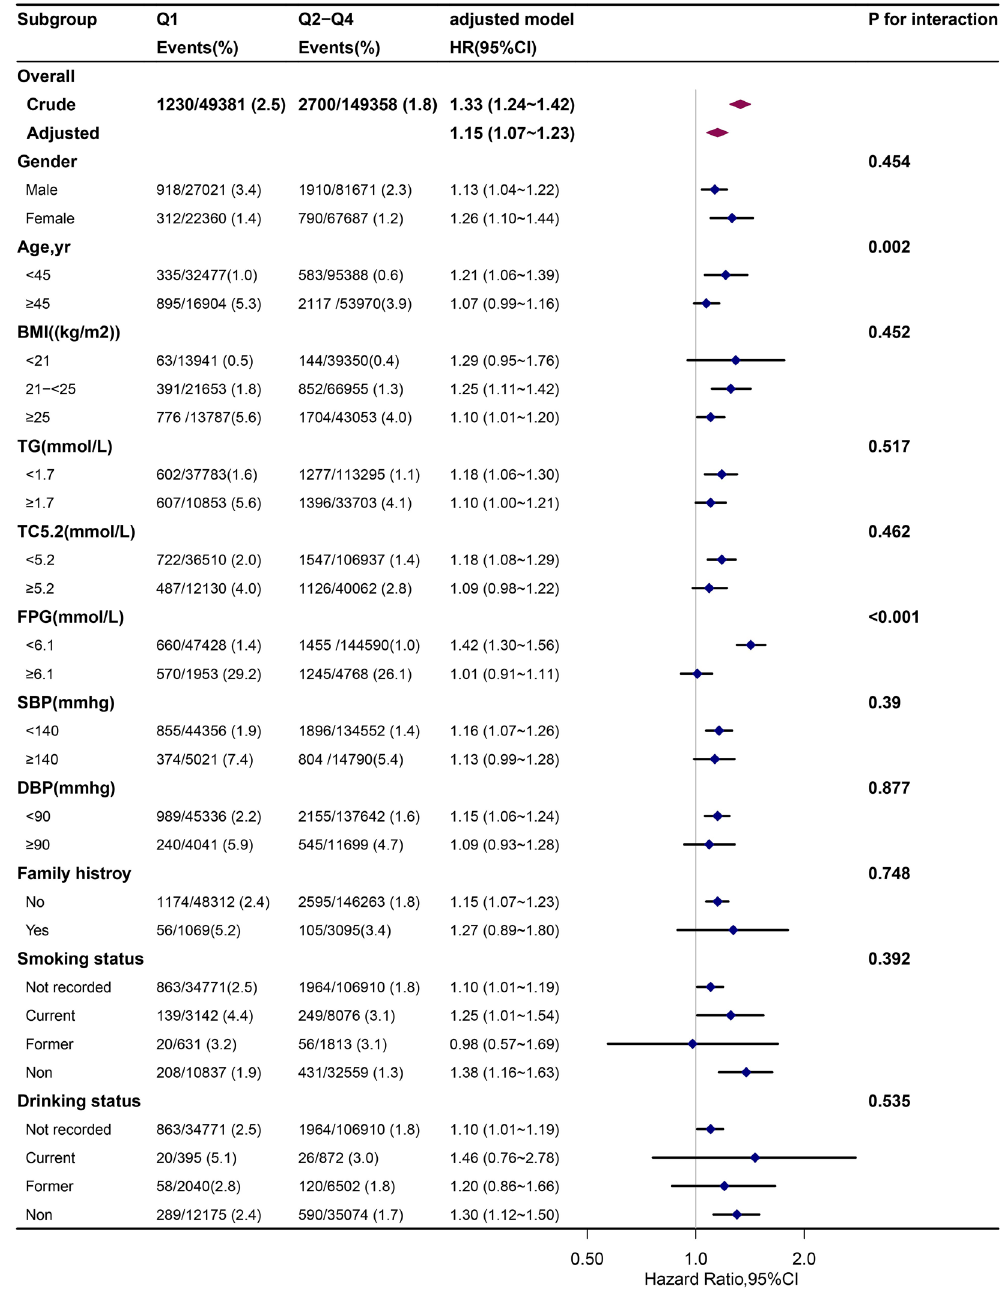
Figure 3. Stratified analysis of the impact of creatinine on new-onset Type 2 Diabetes by other potential effect modifiers. Adjusted for age, sex, body mass index,systolic blood pressure,diastolic blood pressure, fasting plasma glucose, total cholesterol, triglyceride, blood urea nitrogen, alanine aminotransferase, drinking status, smoking status and family history of diabetes, if not be stratified. Boxes denote odds ratios (ORs), lines represent 95% CIs. BMI body mass index, SBP systolic blood pressure, DBP diastolic blood pressure, FPG fasting plasma glucose, TC total cholesterol, TG